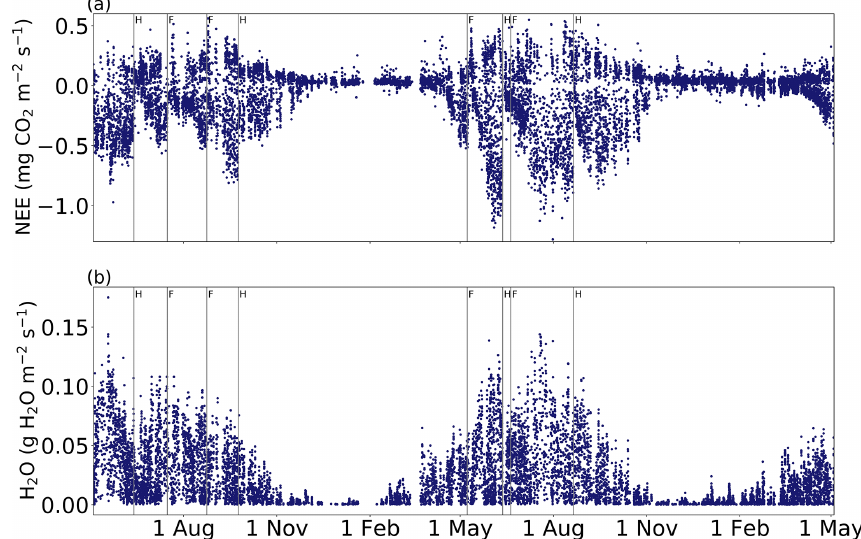
Figure 3. Accepted 30min (a) net ecosystem exchange (NEE) and (b) H 2 O flux measurements from May 2018 to May 2020. Vertical lines with H and F indicate harvest and fertilization, respectively.